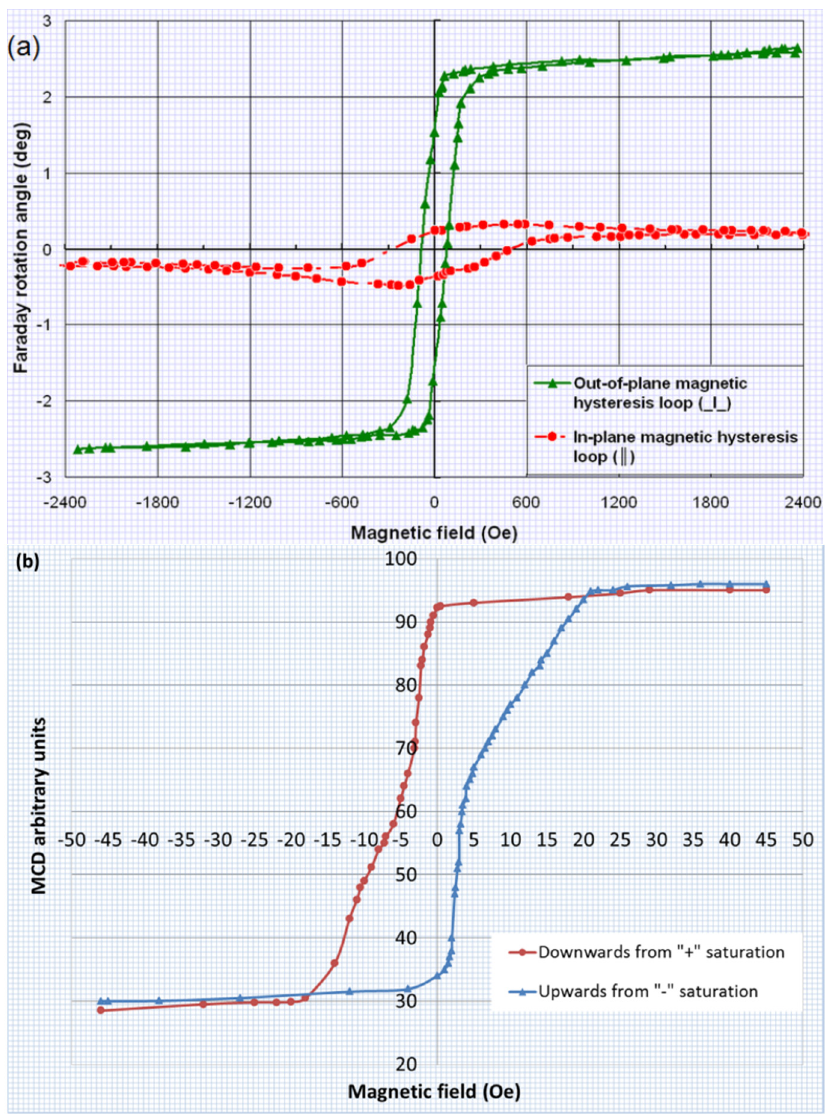
Figure 2. ( a ) Magnetic hysteresis loop obtained in all-garnet multilayer structure (SD 1) described as (Sub (GGG)/(500 nm Bi 2 Dy 1 Fe 4 Ga 1 O 12 )/(500 nm Bi 1.8 Lu 1.2 Fe 3.6 Al 1.4 O 12 )/(500 nm Bi 2 Dy 1 Fe 4 Ga 1 O 12 )) prepared on a GGG (111) substrate (and annealed for 3 h at 630 °C after the deposition) with an external magnetic field applied in the perpendicular (out-of-plane, green color curve) direction with respect to the film plane; ( b ) MCD hysteresis loop measured in an all-garnet multilayer structure (also of SD 1 design type) having thinner layer thicknesses; the graph has been digitized manually from the plotted MCD graph. The sample contained significantly thinner layers as described by (Sub (GGG)/(50 nm Bi 2 Dy 1 Fe 4 Ga 1 O 12 )/(50 nm Bi 1.8 Lu 1.2 Fe 3.6 Al 1.4 O 12 )/(50 nm Bi 2 Dy 1 Fe 4 Ga 1 O 12